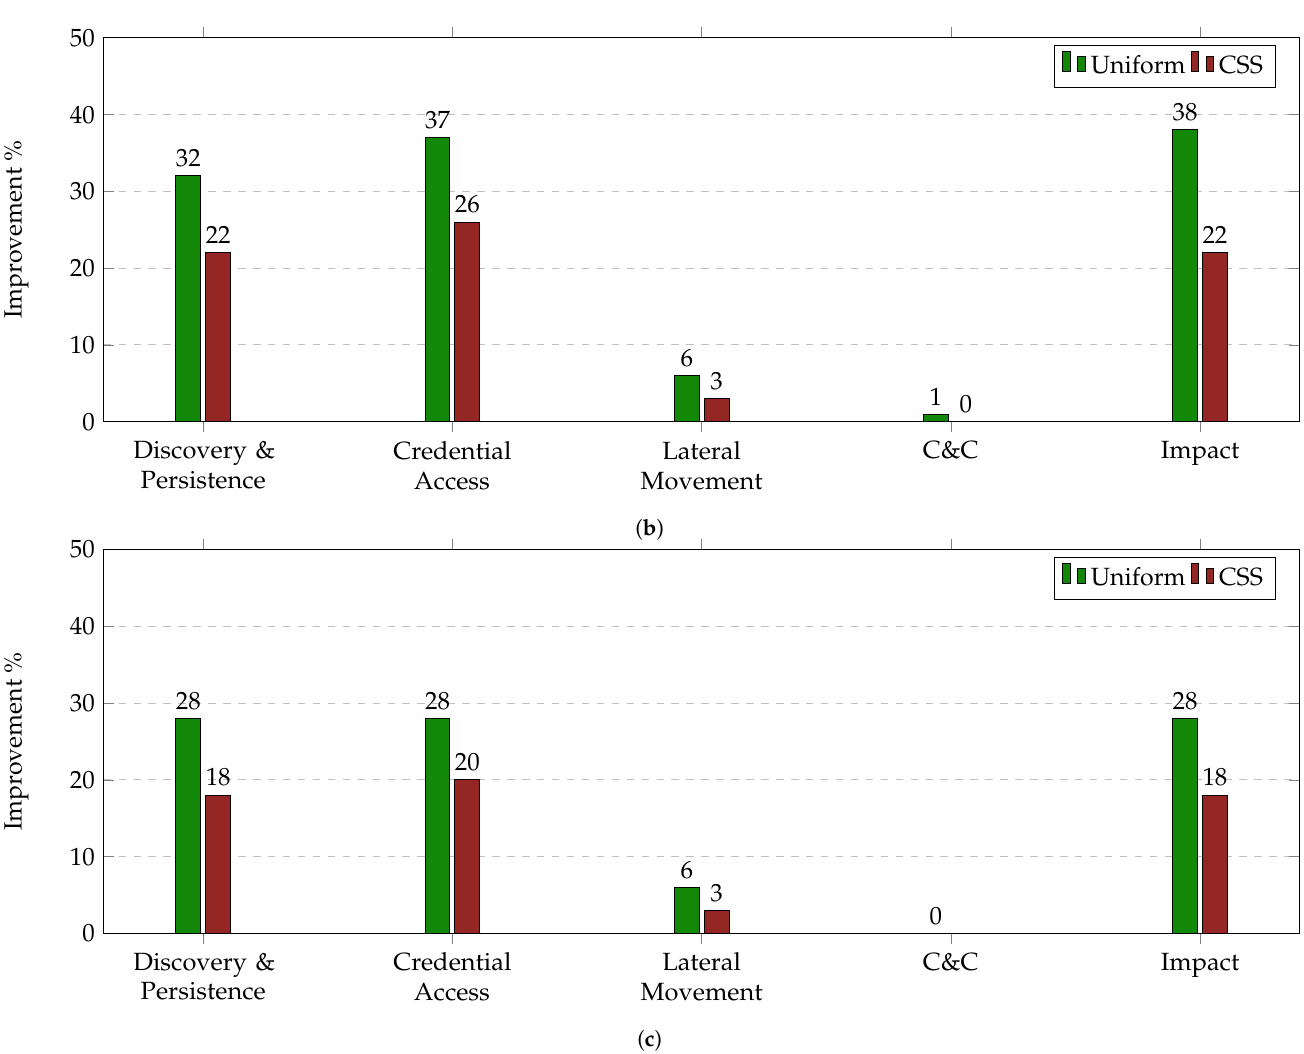
Figure 5. Average improvement of IRP on Uniform and CSS per TTP Tactic on N = 8000 simulated incidents. ( a ) Percentage of IRP improvement per TTP category for Strategic Attacker, ( b ) Percentage of IRP improvement per TTP category for CSS Attacker, ( c ) Percentage of IRP improvement per TTP category for Uniform